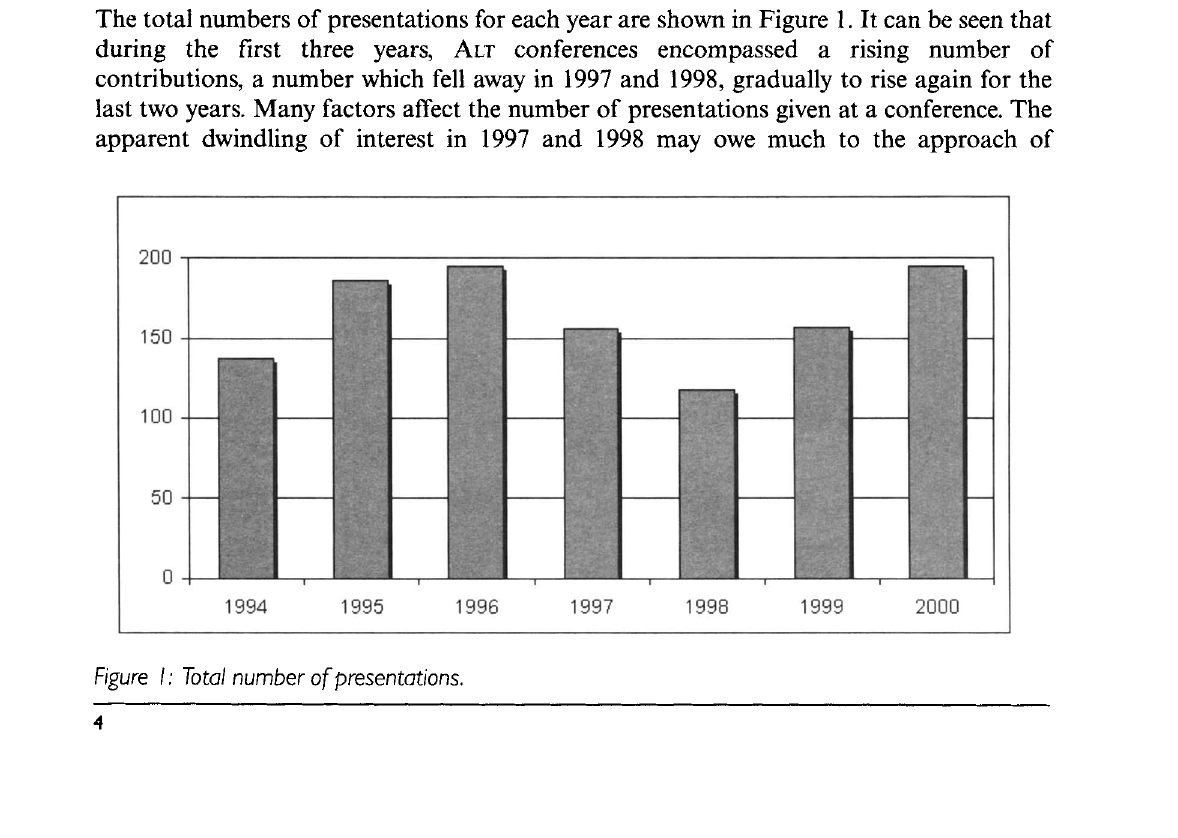
Figure I: Total number of